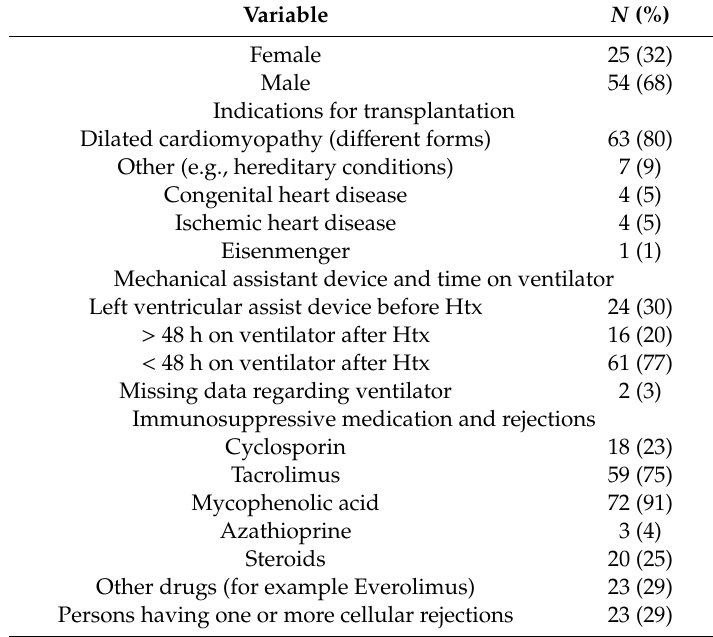
Demographics, indications for transplantation and relevant clinical aspects among 79 heart